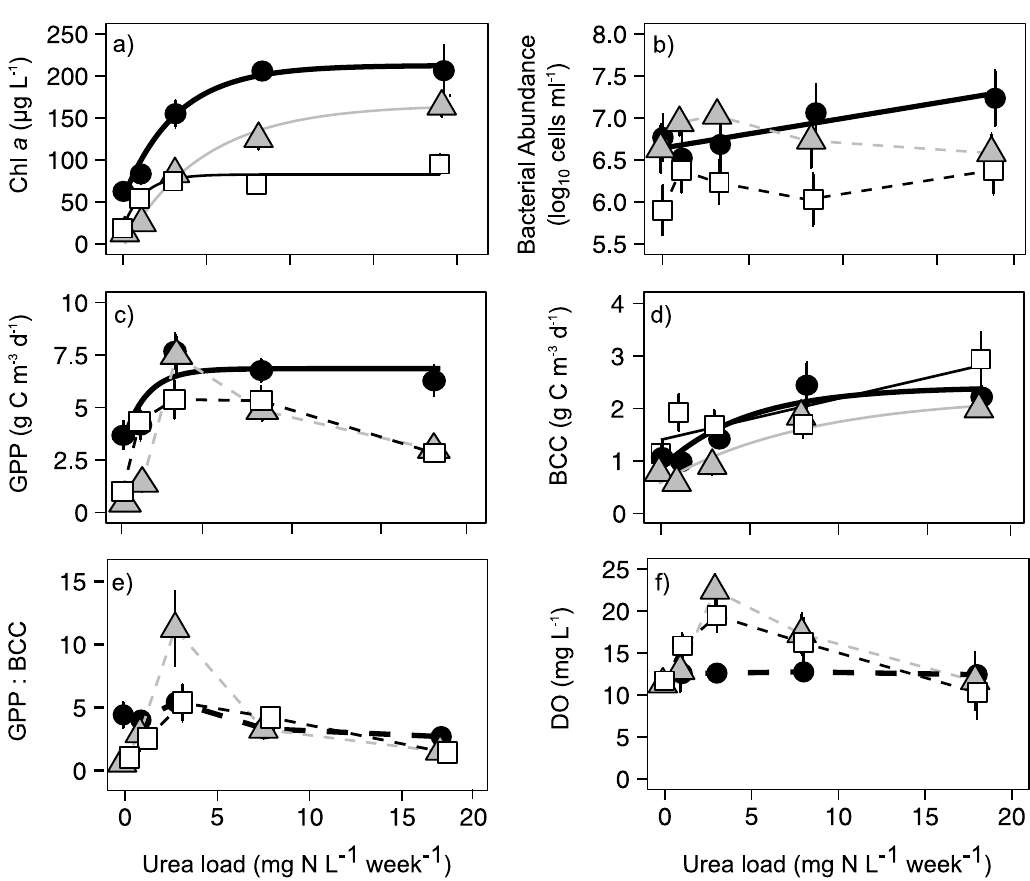
Fig 2. Effects of urea fertilization rate (mg N L -1 week -1 ) on mean planktonic parameters. Results averaged for days 7–21. Responsevariables include(a) phytoplankton biomass (as Chl a ), (b) bacterialdensity, (c) gross primary production(GPP), (d) bacterial C consumption (BCC; productivity + respiration), (e) the approximate metabolicbalance of planktoncommunities,measured as GPP: BCC, and (f) dissolvedoxygen concentration (DO). Data in each panel includesJuly (black circles and thick black lines), August (grey trianglesand grey lines), and September (white squares and thin black lines) experiments. Solid lines indicatebest-fit regressionmodels detailedin Table 1, dashedlines indicate direction of change for trial in which statistically-significantregressionmodels could not be fit. Error bars = ± 1 S.E, and n = 9.